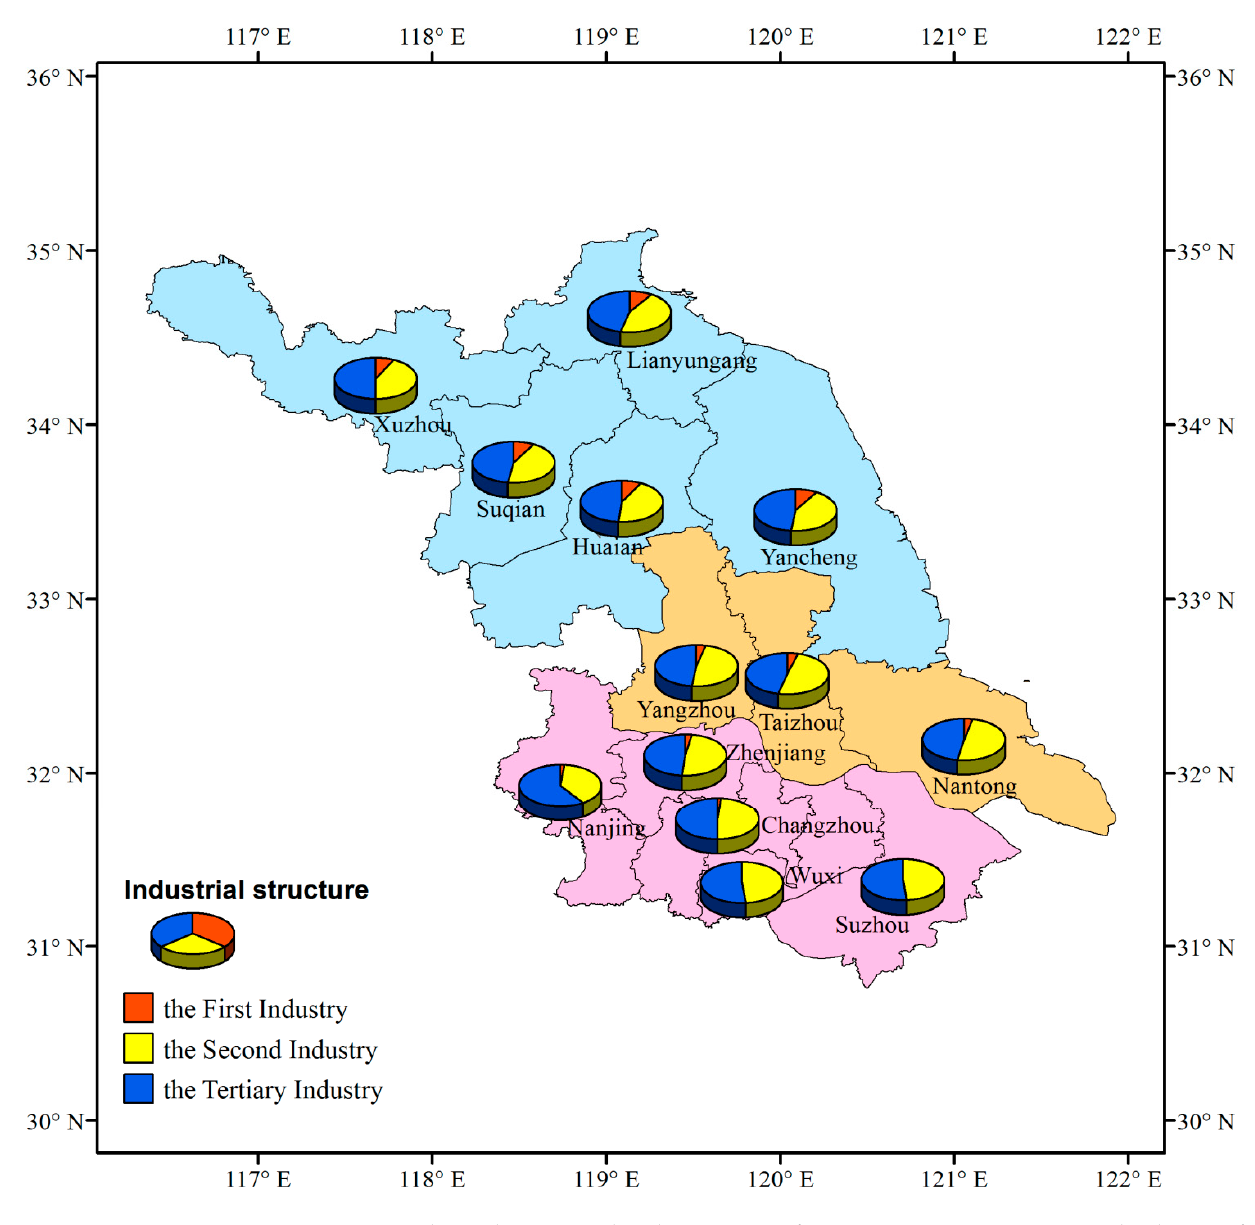
Figure 6. Industrial structure distribution map of 13 cities in Jiangsu Province. The data are from the Jiangsu Statistical Yearbook 2020 , http://tj.jiangsu.gov.cn/2020/nj20/nj2006.htm, accessed on 10 March 2022.